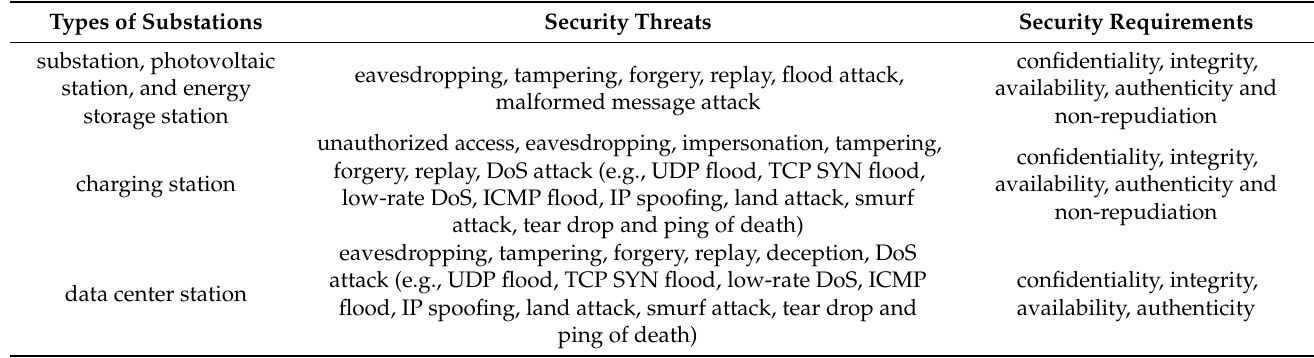
Table 1. Security threats and requirements of